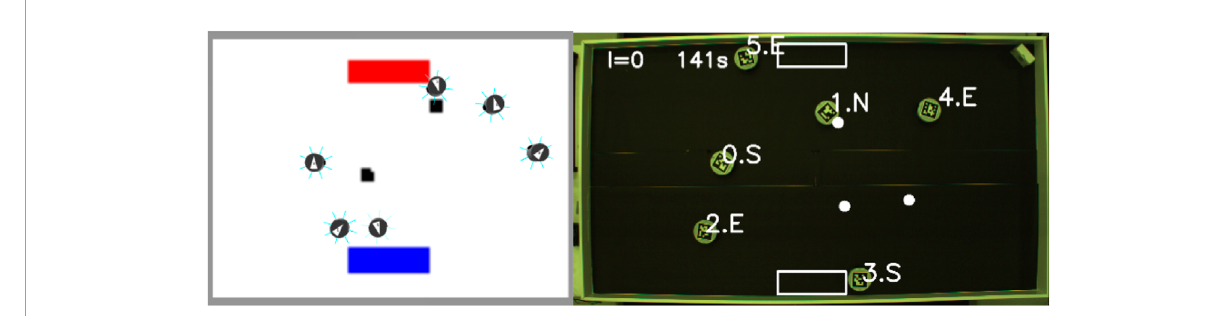
FIGURE 12 Screenshot of one of the experiments in simulation (left) and hardware (right).